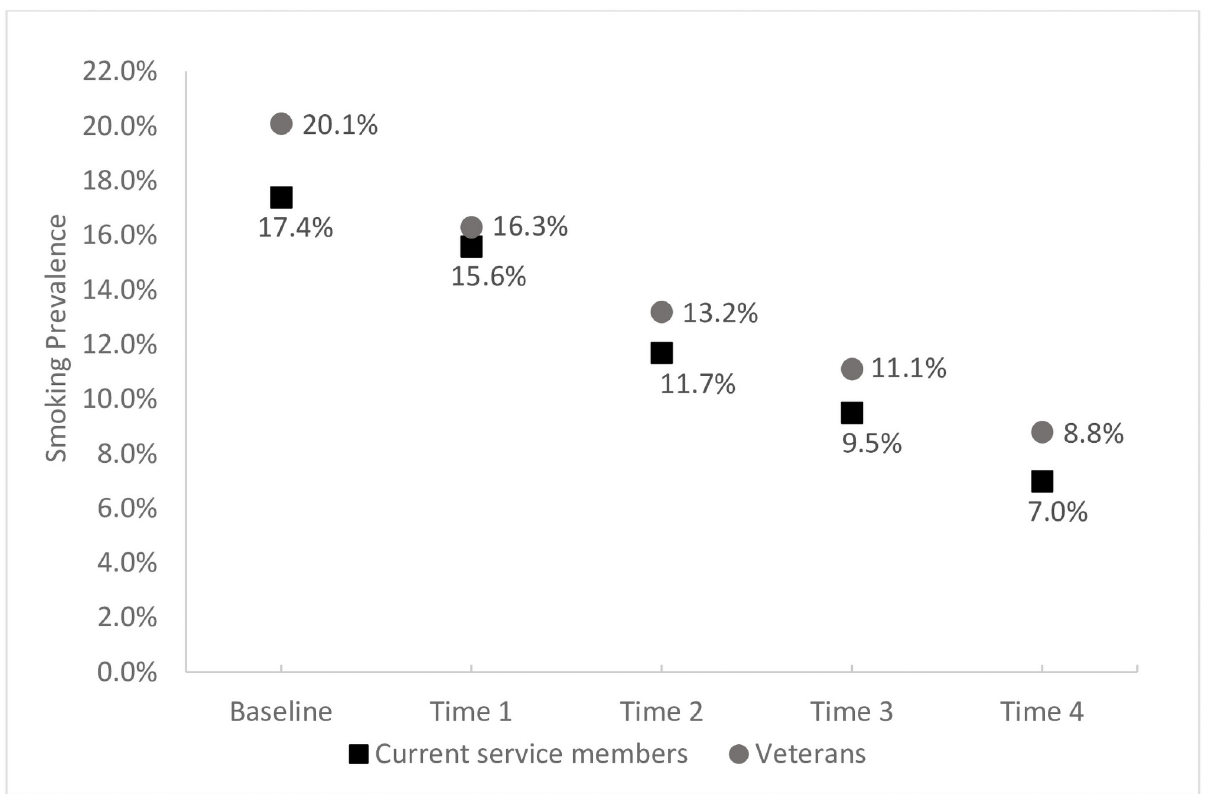
Fig 2. Prevalence of smoking by separation status and time. Both Service members and veterans showed a statistically significant decline in smoking prevalence over time (p = 0.0005 and 0.0009, respectively). Prevalence rates between Service members and veterans are not significantly different at alpha = 0.05